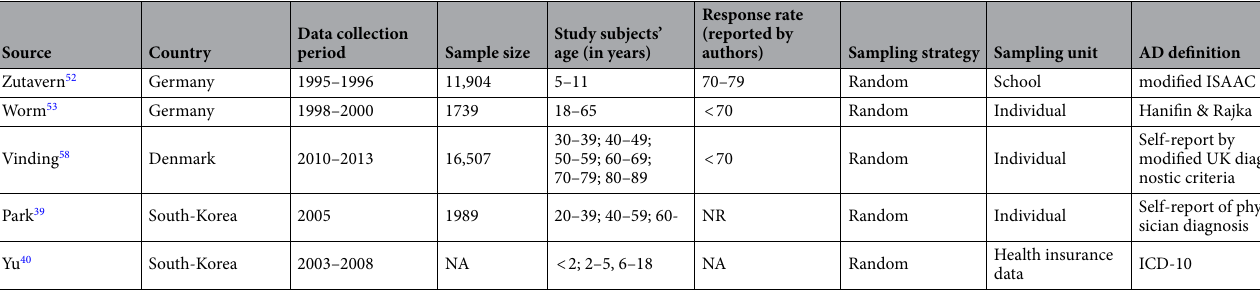
Table 1. Characteristics of included studies. AD—atopic dermatitis; NR—not reported; NA—not applicable; ISAAC—criteria of the International Study of Asthma and Allergies in Childhood; Hanifin & Rajka—self- reported score of symptoms based on the Hanifin and Rajka criteria; UK—physician’s diagnosis based on UK refinement of diagnostic criteria; ICD-10—physician’s diagnosis according to ICD-10.